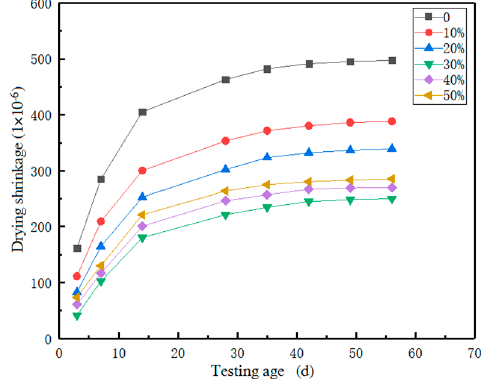
Figure 12. The drying shrinkage curve of the recycled brick powder UHPC.